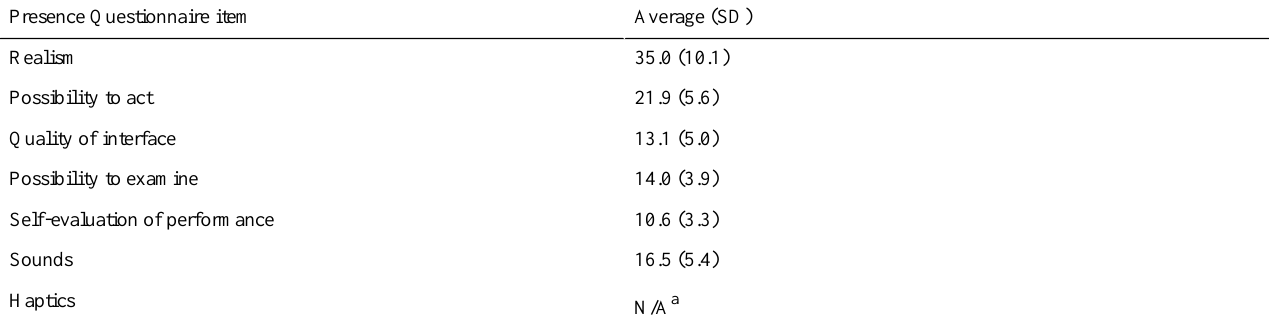
Table 3. The average rating scores on the 7 Presence Questionnaire items indicate the participants’ experience of their presence in ALS-SimVR, a virtual reality Advanced Life Support training